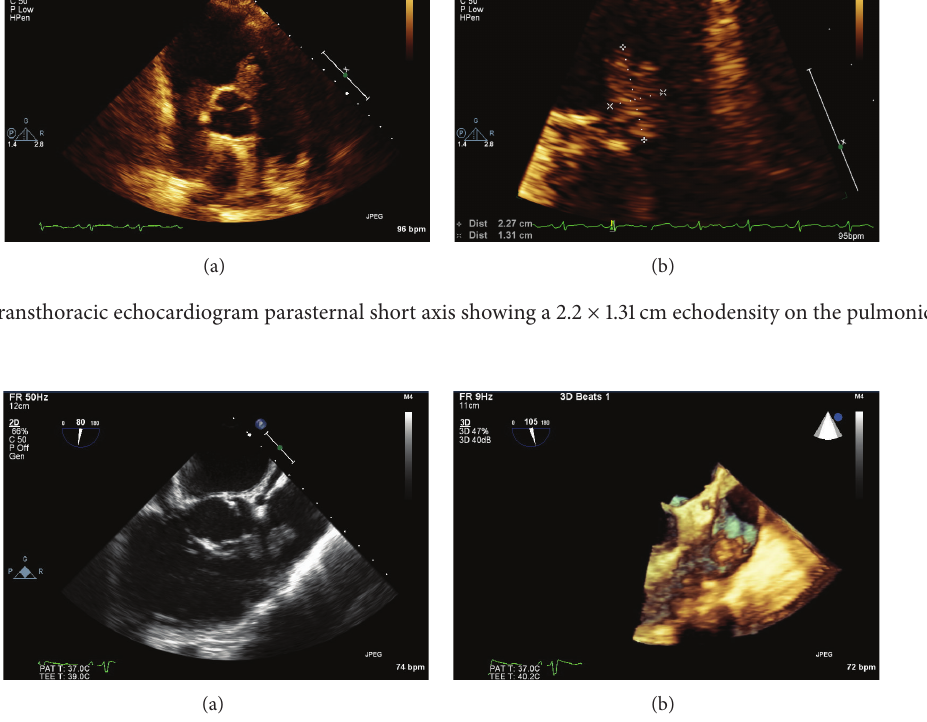
Figure 2: Transesophageal echocardiogram with a 2.4 × 1.8 cm echodense mobile mass seen on the pulmonic valve consistent with large vegetation in 2D and 3D